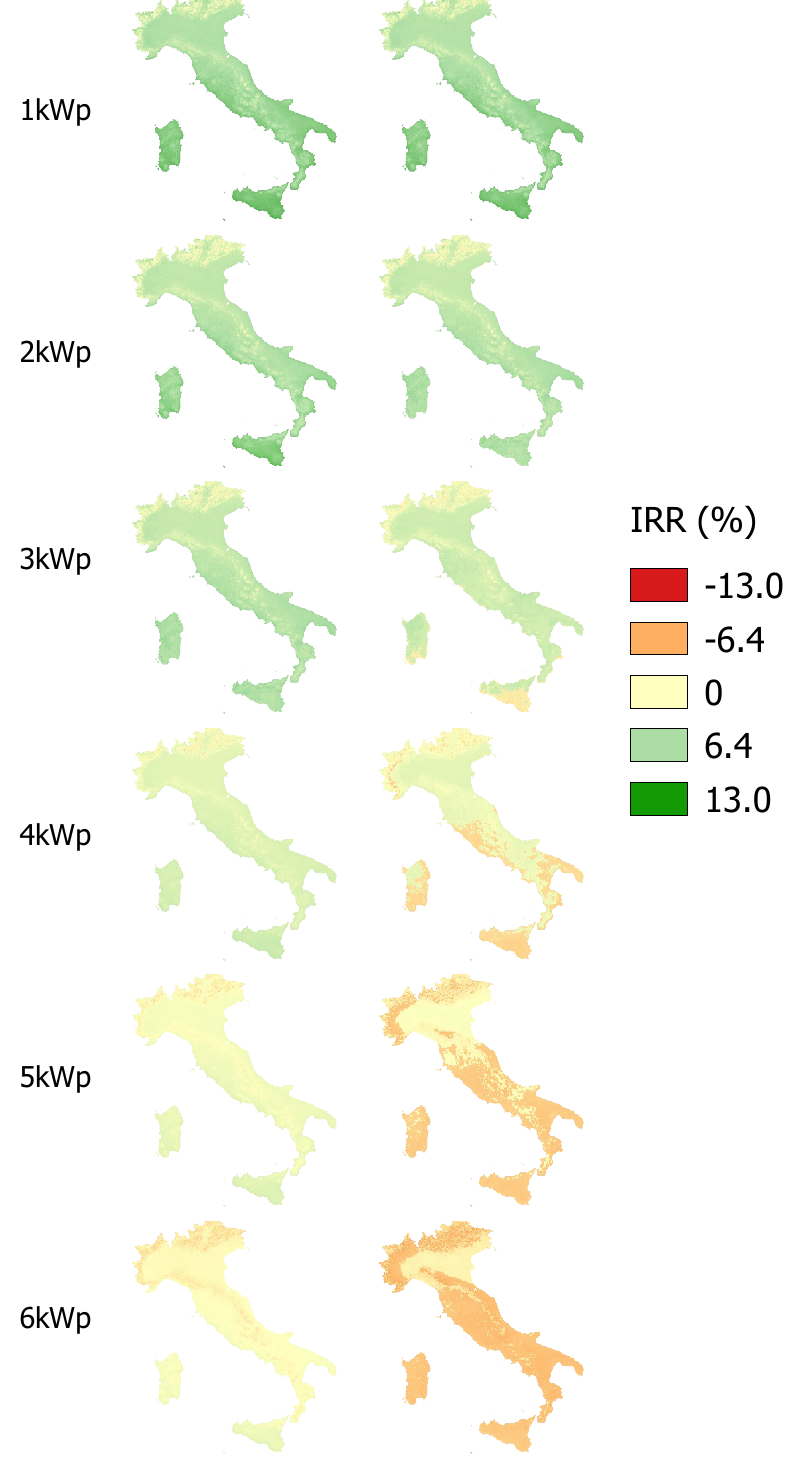
Figure A12. IRR for E L = 4000 kWh, left side without battery and right side with